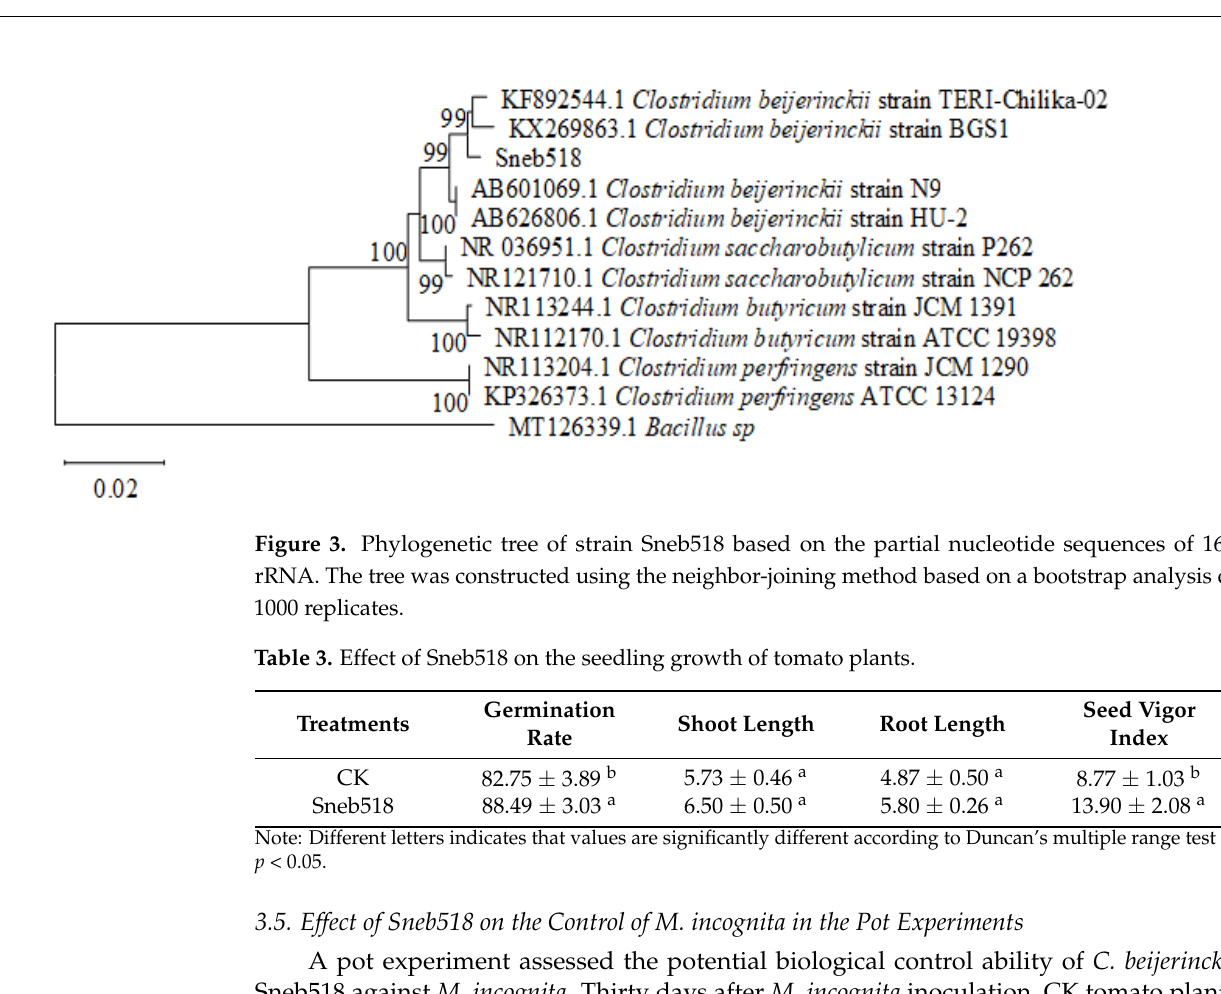
Figure 2. Morphological characteristics of bacteria isolate Sneb518. Left: The morphological charac-